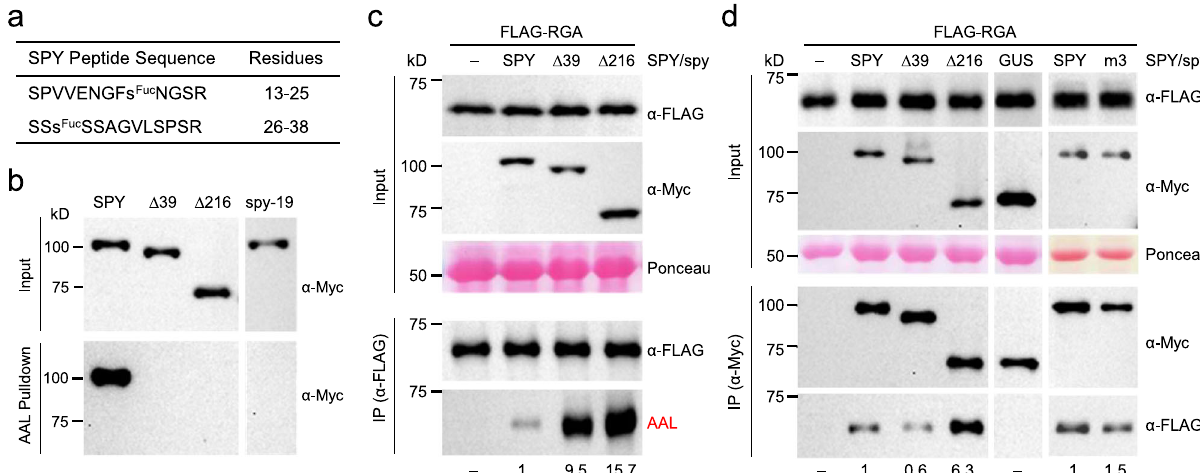
Fig.4|Auto-fucosylationofSPYandtheinhibitoryroleofitsN-terminalregion on POFUT activity. a , b SPY was auto- O -fucosylated in planta. Myc-SPY or spy mutant proteins were transiently expressed in N. benthamiana . Δ 39 and Δ 216: truncated spy proteins with deletions of 39 and 216 a.a. from the N-terminus. spy- 19, a biochemically null mutant with K665M 3 . In ( a ), two O -fucosylation sites (S21 and S28) in SPY were identi fi ed by ETD-MS/MS analysis (Supplementary Figs. 7, 8). In ( b ), the full-length SPY wasauto- O -fucosylated, whereasnone of the mutant spy proteins was fucosylated. O -fucosylated proteins were pulled down by AAL- agarose. Immunoblot containing input (top panel) or AAL-agarose pull-down samples (bottom panel) was probed with an anti-Myc antibody. Representative images of three biological repeats are shown. c Deletion of N-terminal peptide ( Δ 39)and TPRs 1 – 5 ( Δ 216) inSPY enhancedits POFUTactivity inplanta.FLAG-RGA was expressed alone ( − ) or co-expressed with Myc-SPY or spy in N. benthamiana . Toppanel(Input):Immunoblotscontainingtotalproteinextracts.Bottompanel( α